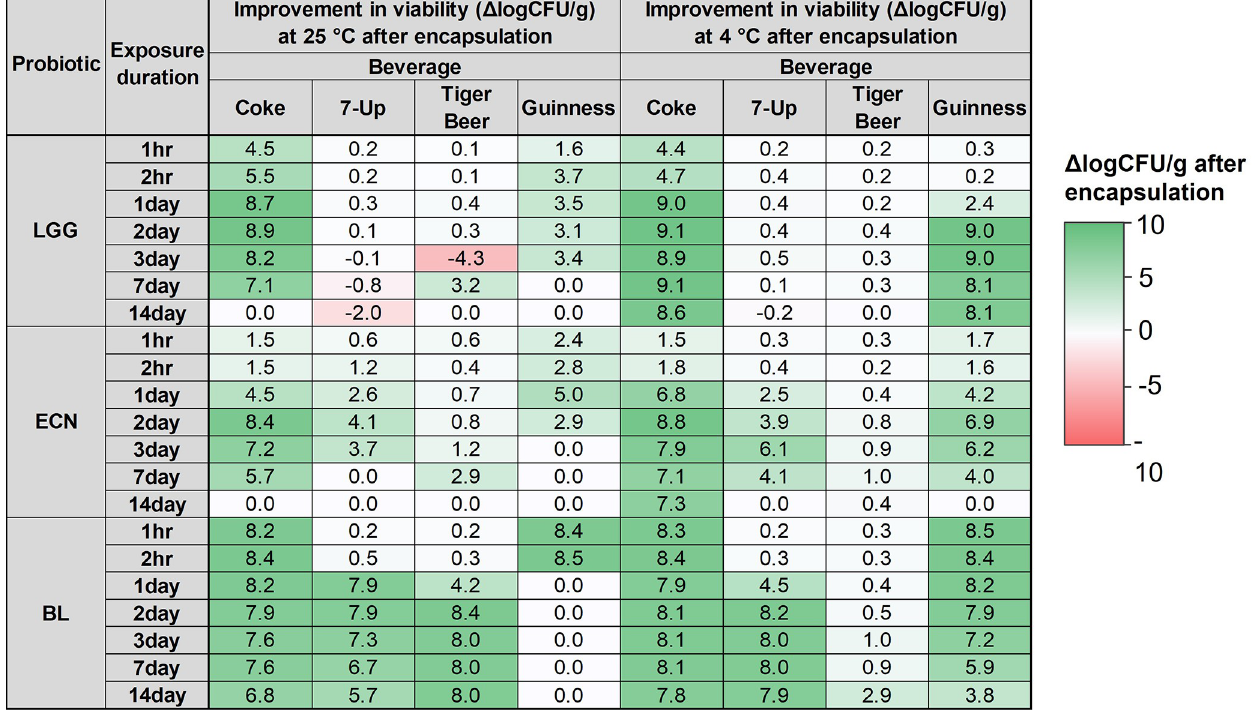
Fig 5. Heatmap showing improvement in probiotics viability after alginate encapsulation.